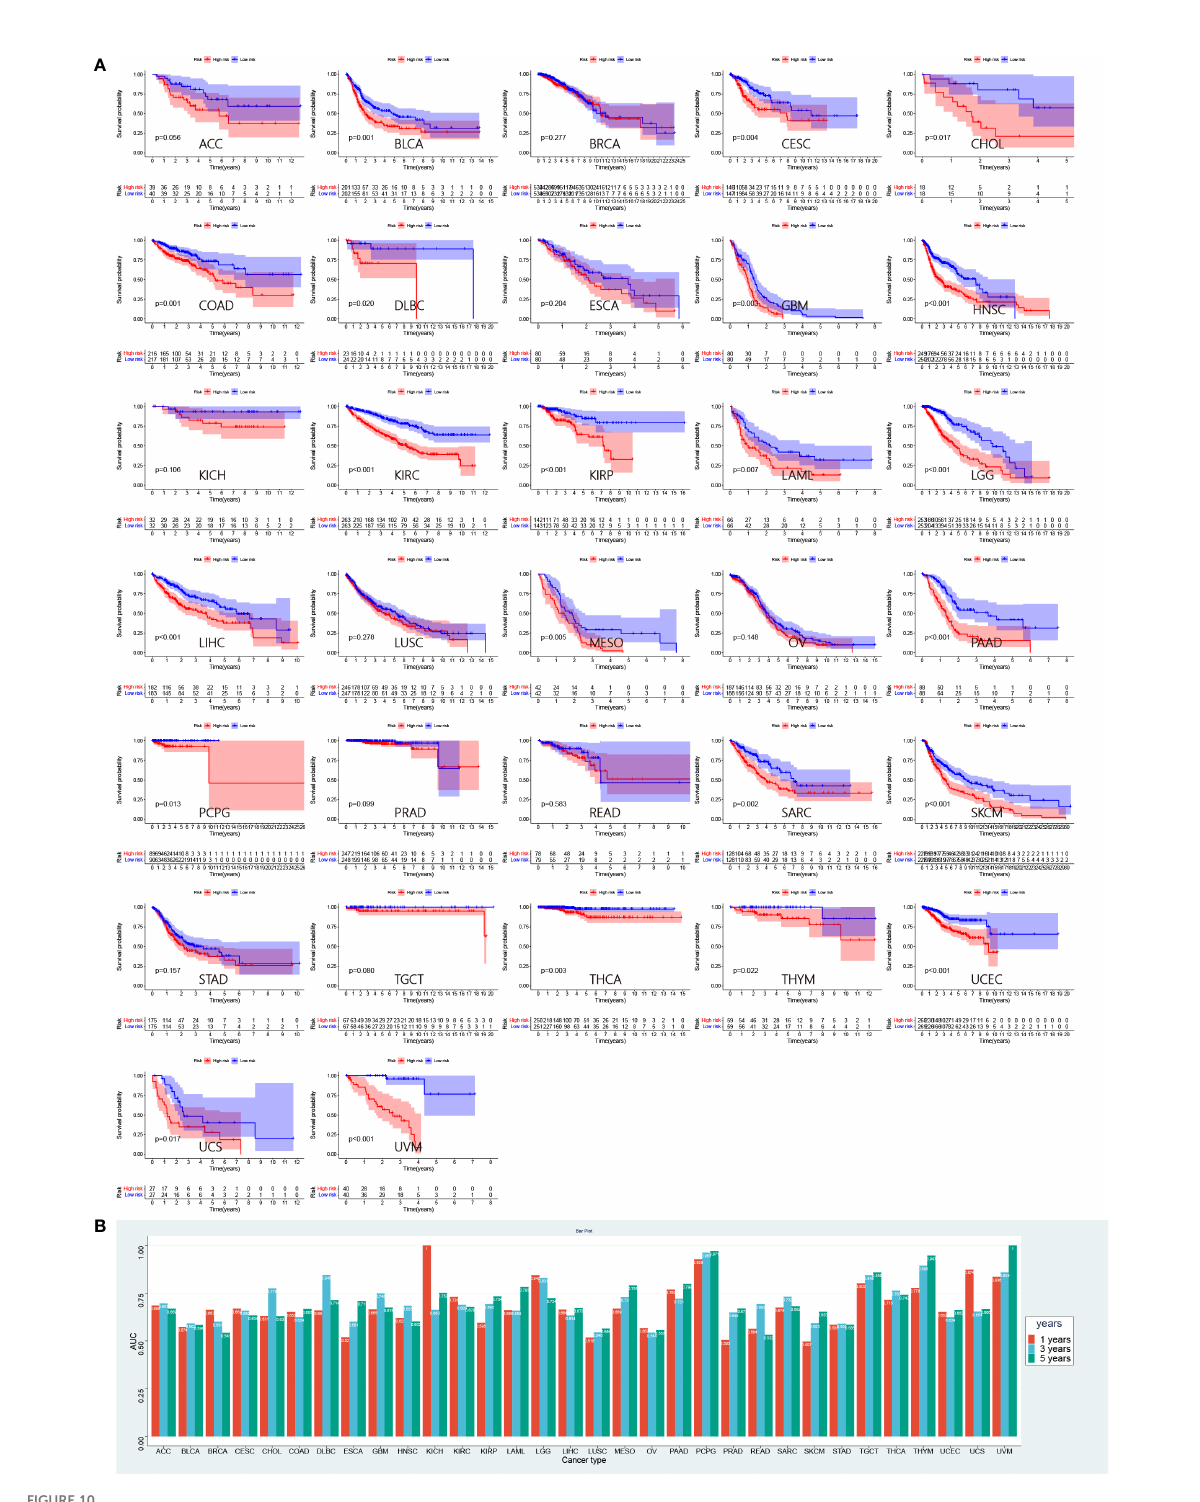
FIGURE 10 Prognostic validation of risk score in pan-cancer. (A) Survival analyses between low- and high-risk group in 32 pan-caner cohorts of TCGA. (B) Corresponding AUC values in 32 pan-cancer